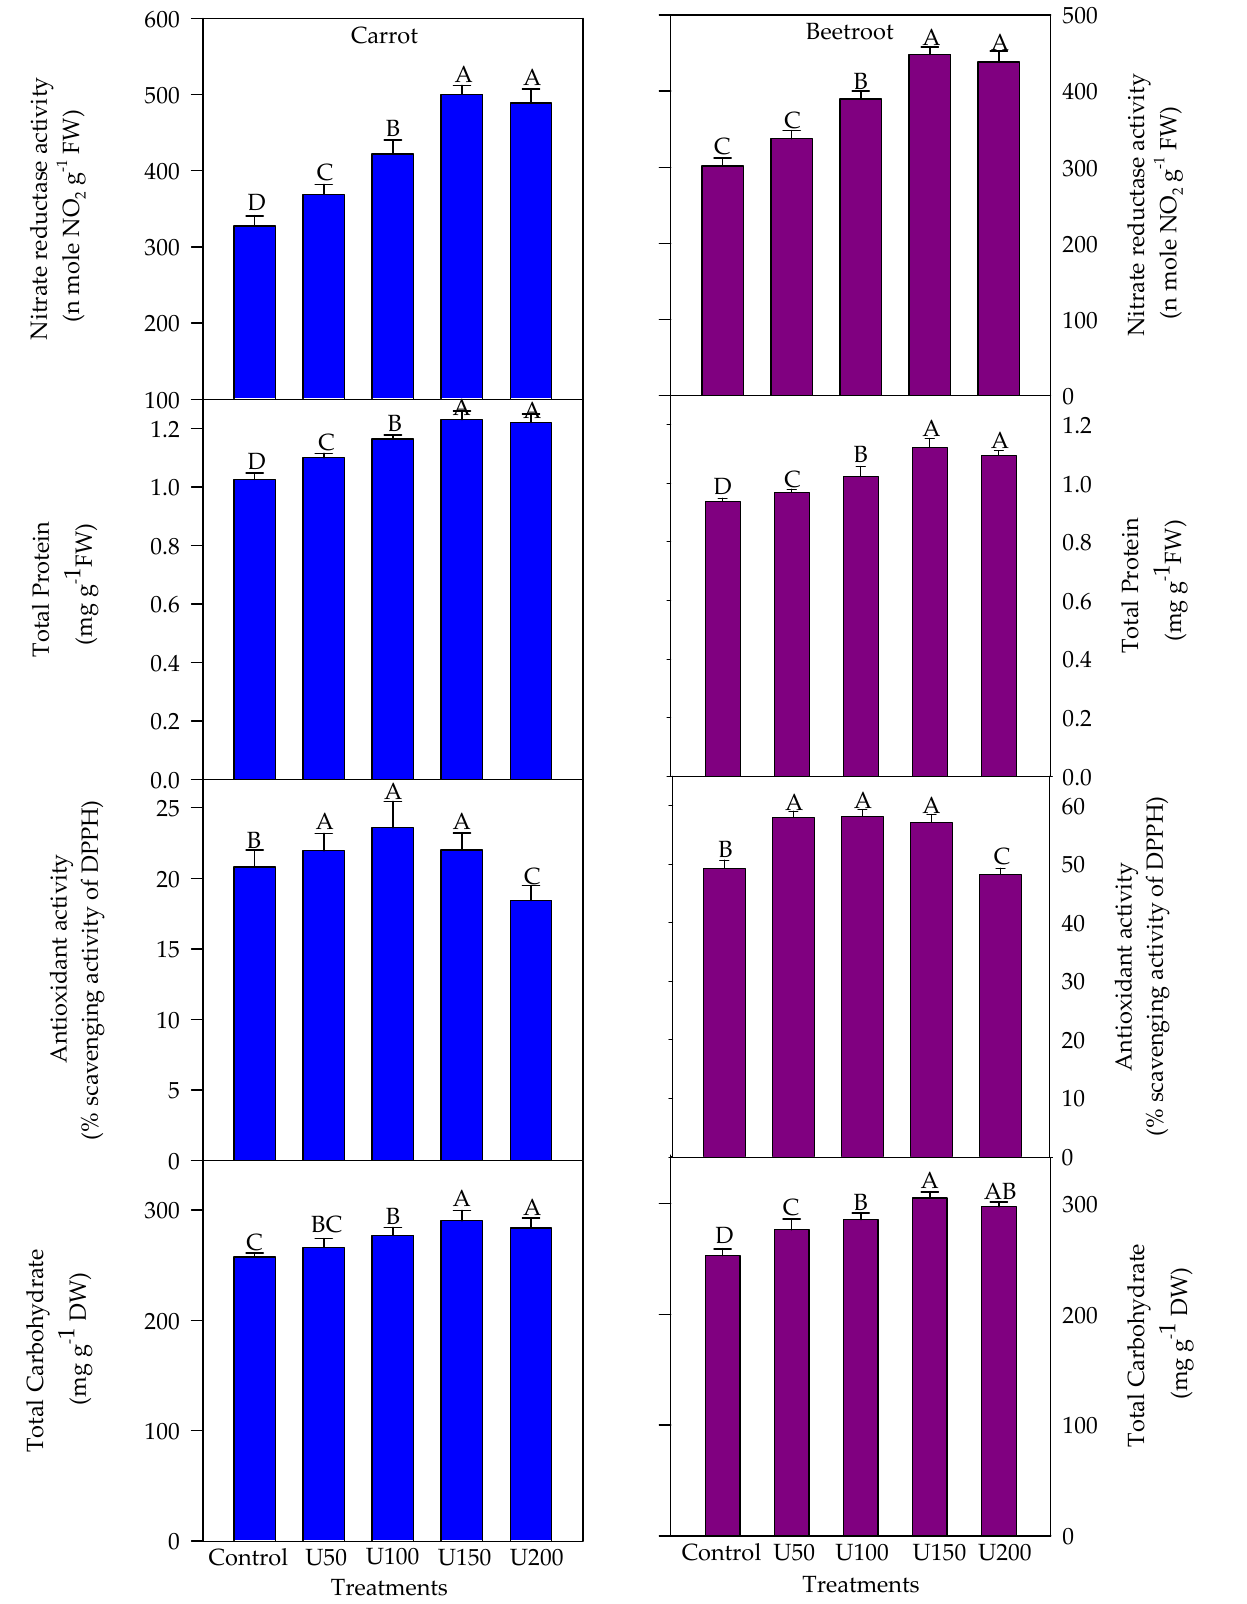
Figure 5. Impact of different N levels on the biochemical attributes, and antioxidant activity of carrot and beetroot. Data from experiments are collected as the mean of three replicates ± standard error (SE). Data represent mean of three independent replicates ± standard error